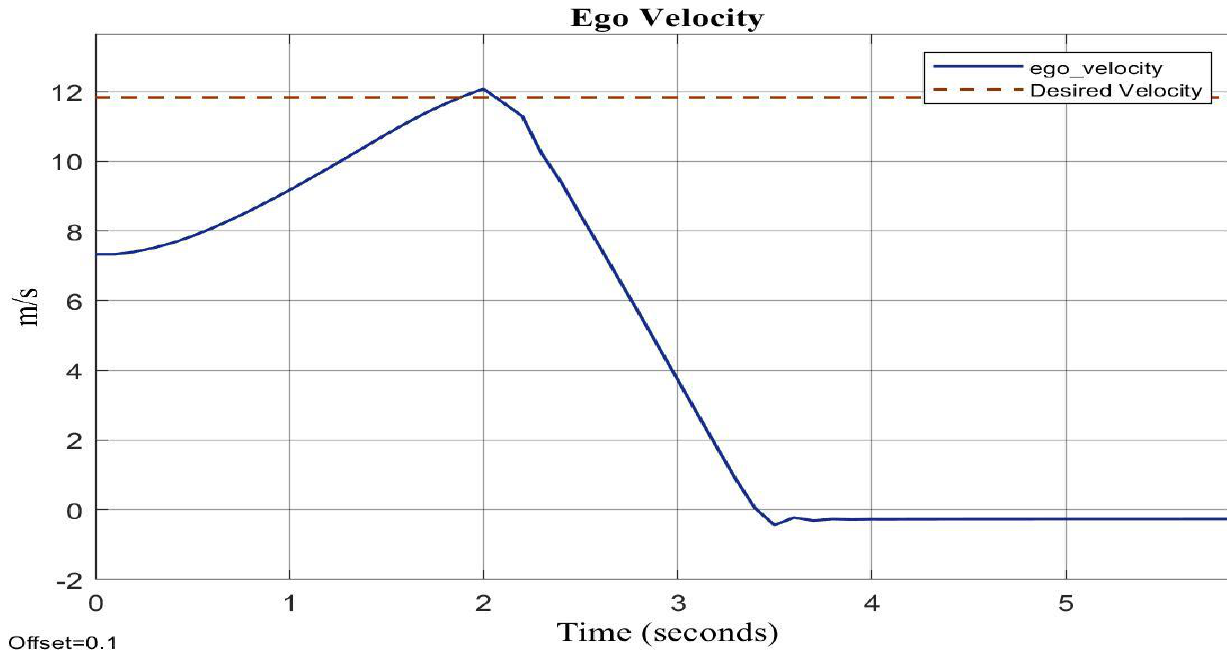
Figure 19. The velocity of the vehicle when various stages of brakes are applied.